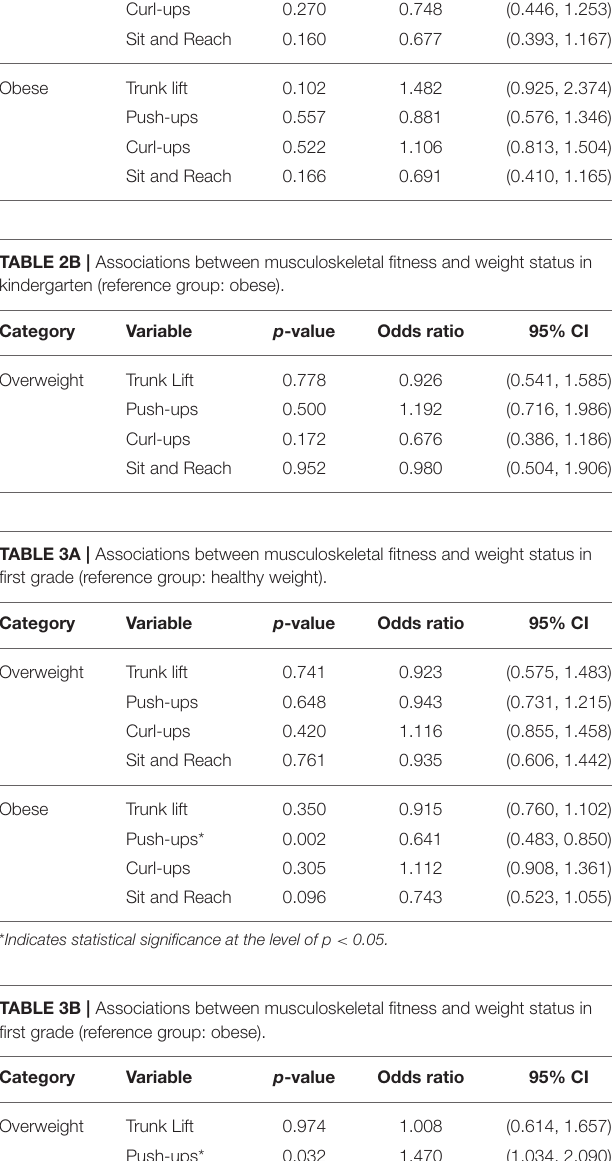
TABLE 2A | Fitness associations in kindergarten (reference group: healthy weight). Category Overweight